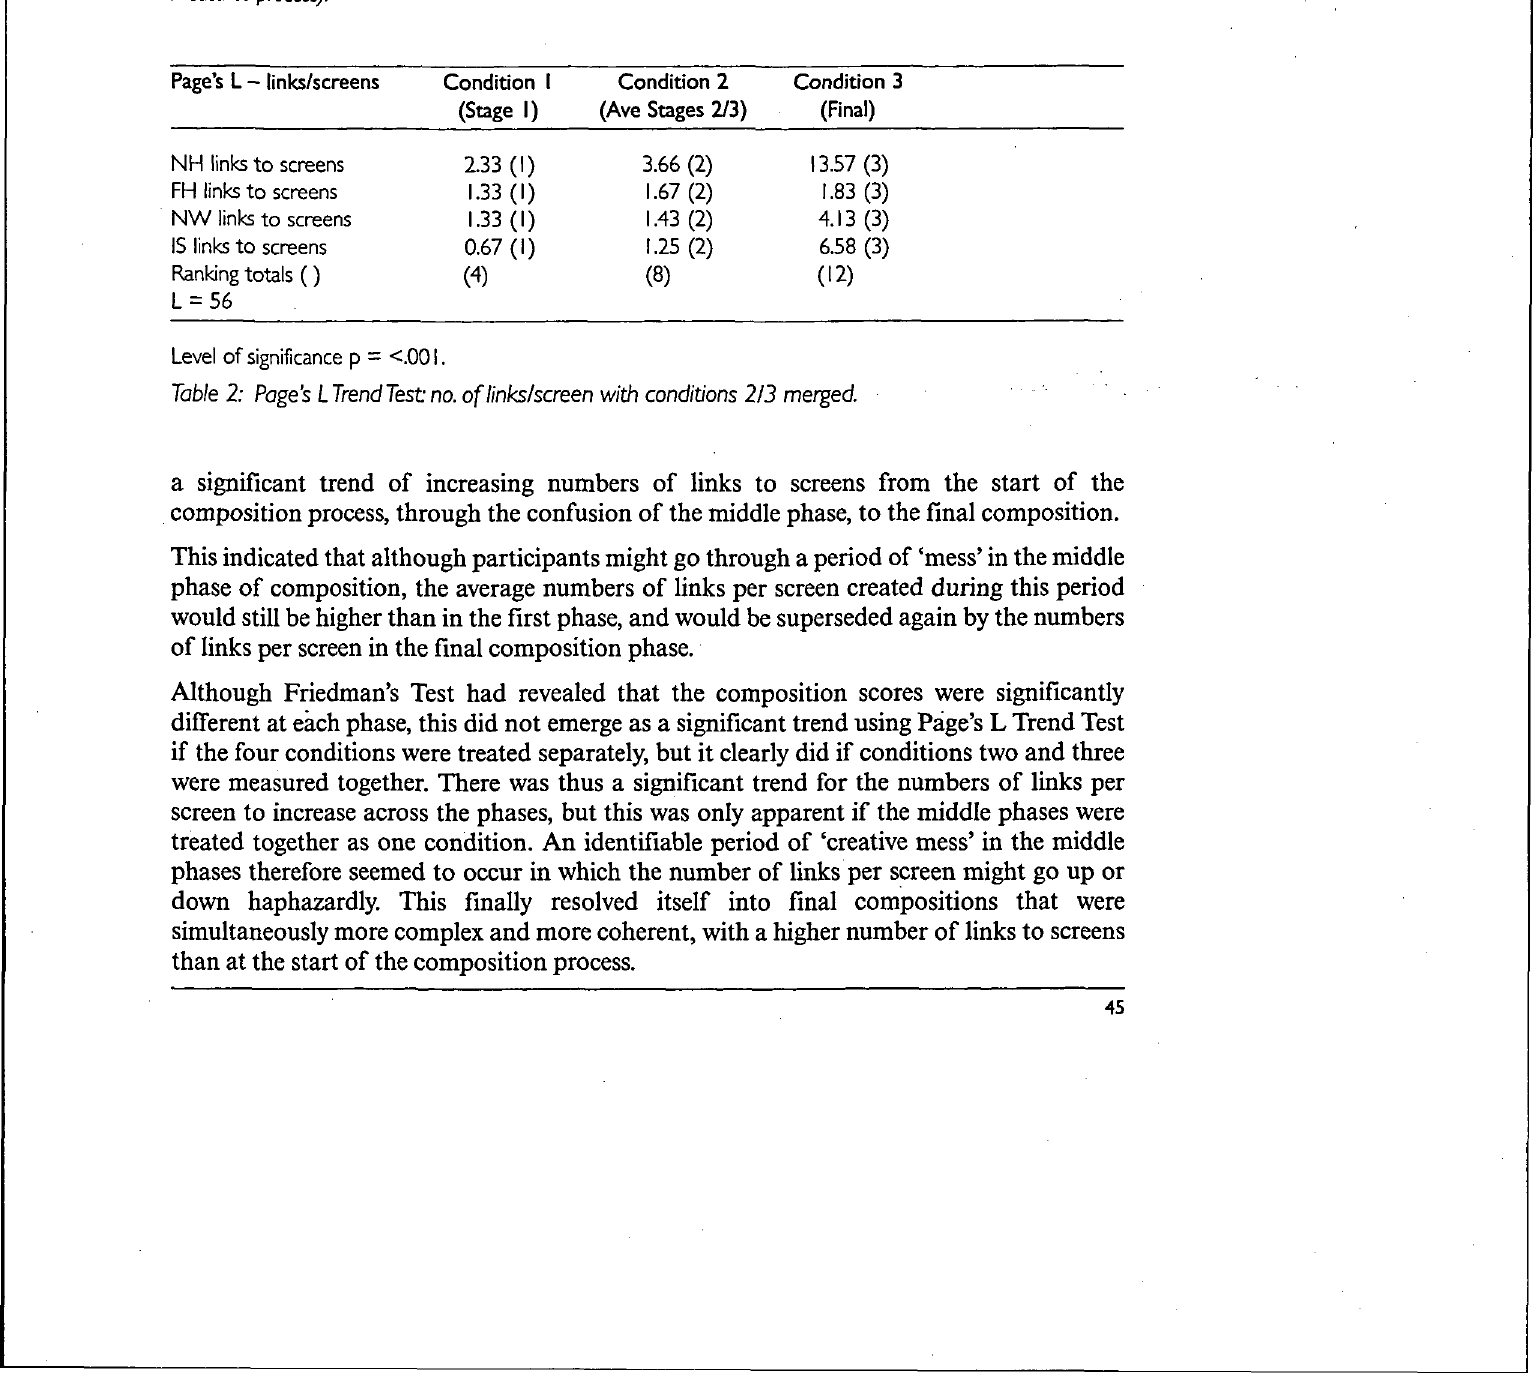
Table I: Page's L Trend Test no. of links per screen.